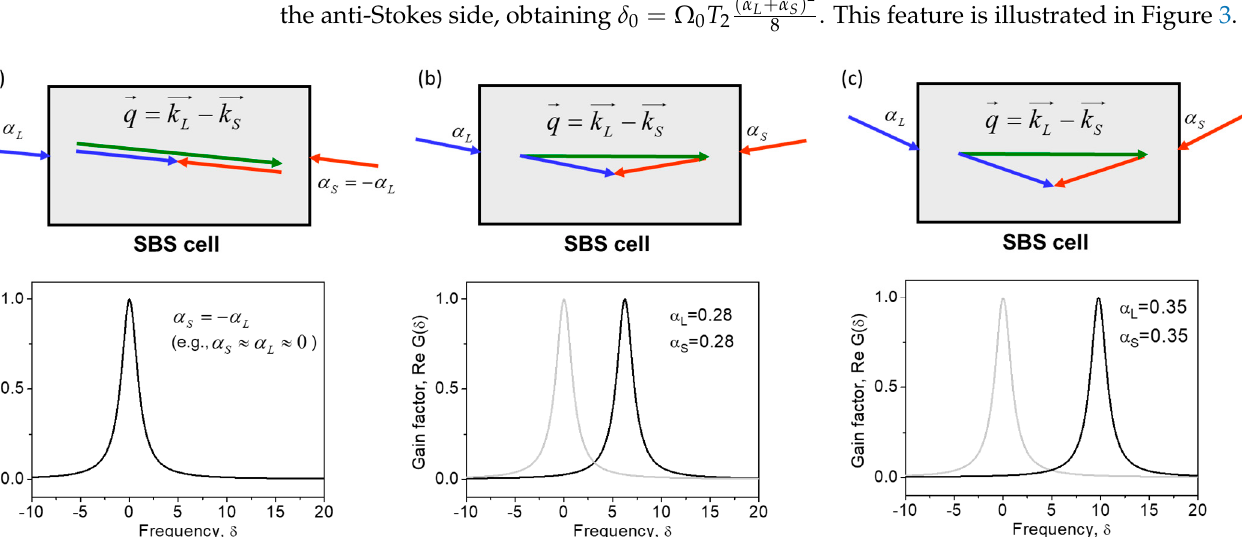
α α= − α α= − , the interacting waves are S S